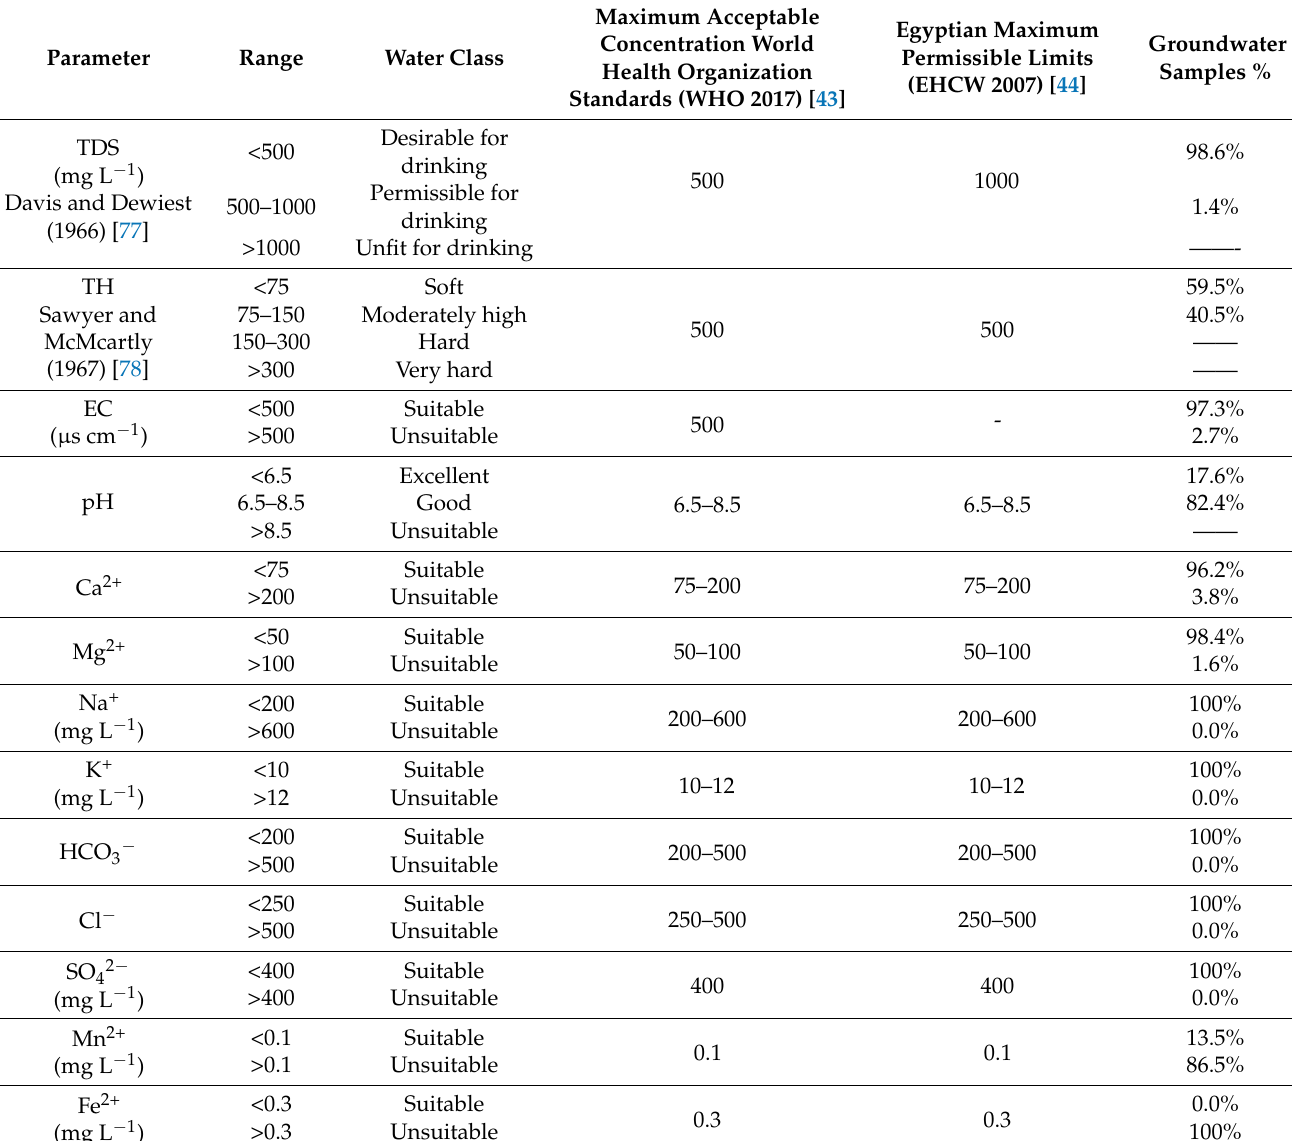
Table 3. Physicochemical data of groundwater samples comparing with Egyptian and WHO